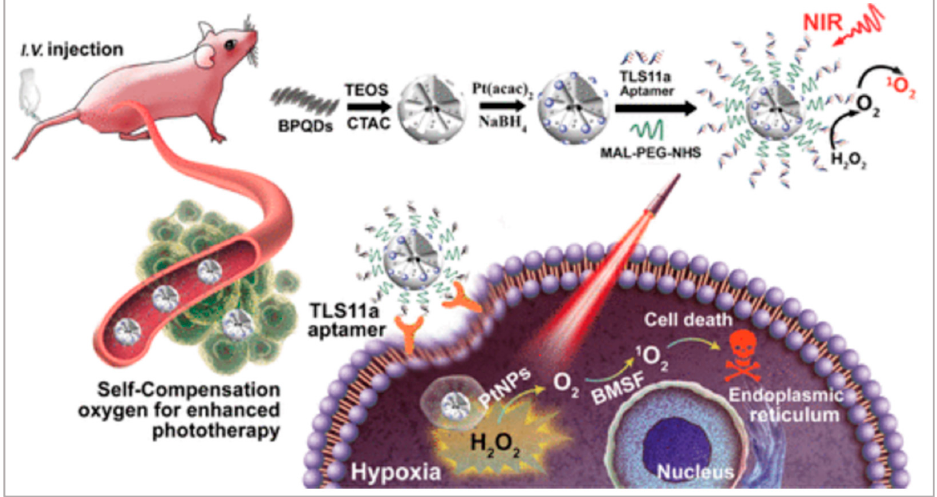
Figure 9. Schematic illustration of the self-regulation of precise cancer phototherapy. Reprinted with permission from [114]. Copyright © 2019 American Chemical